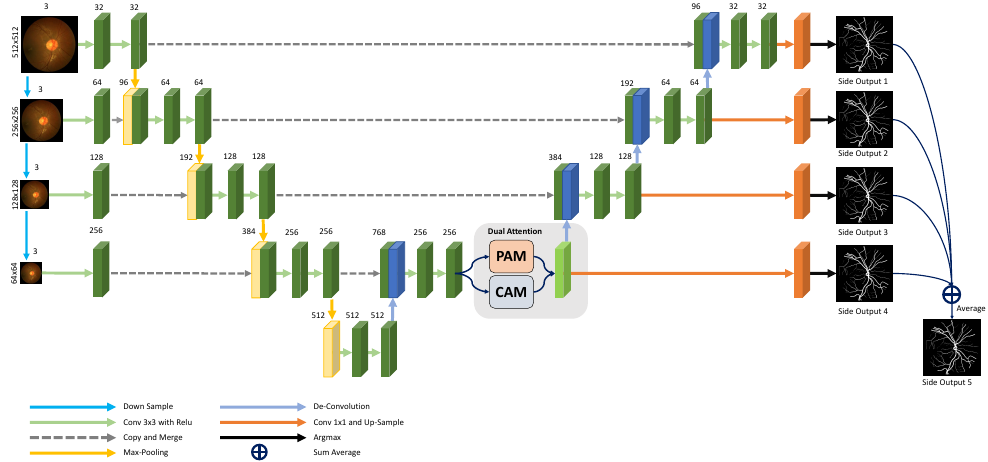
Figure 1. The proposed vessel segmentation